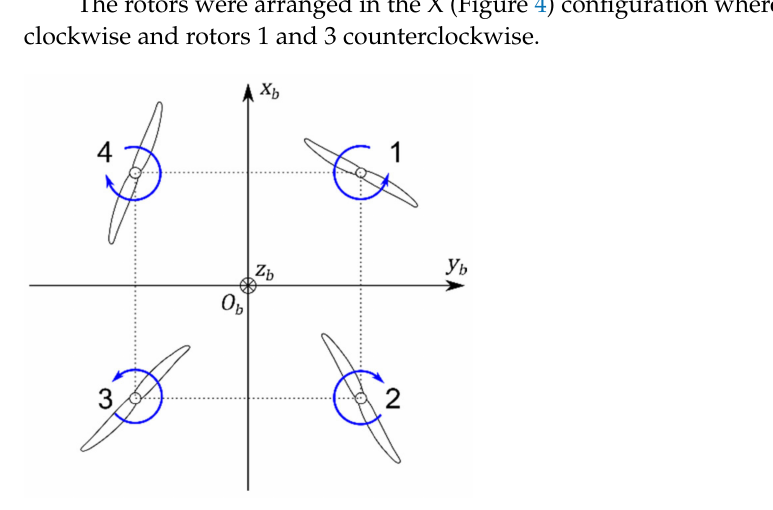
Figure 4. Rotors configuration (top